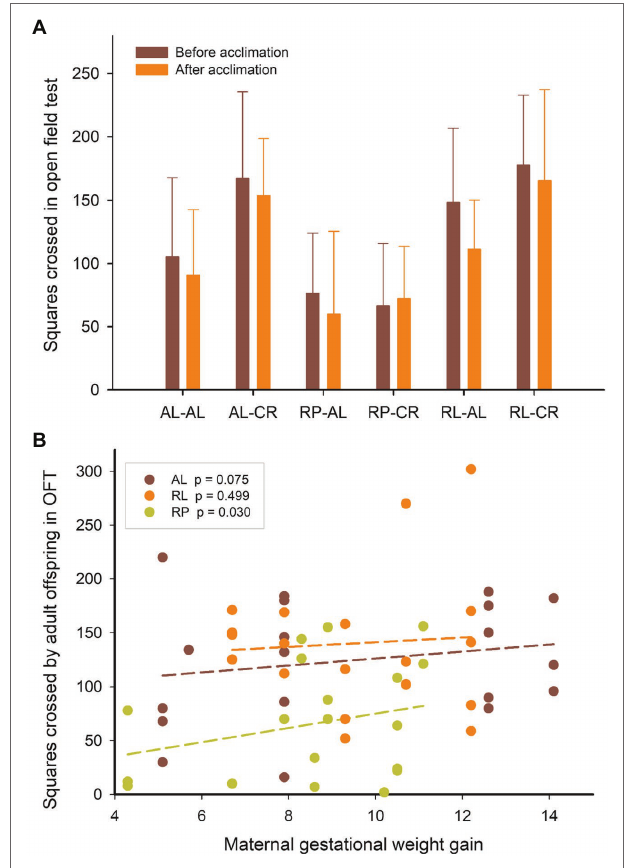
FIGURE 7 | (A) Enzymatic activity of citrate synthase and cytochrome c oxidase from skeletal muscle of adult male BALB/c mice, from six treatments of perinatal and adult food availability. (B) Relationship between offspring enzymatic activity and body weight of their mothers at the end of pregnancy. See statistical results in main text.